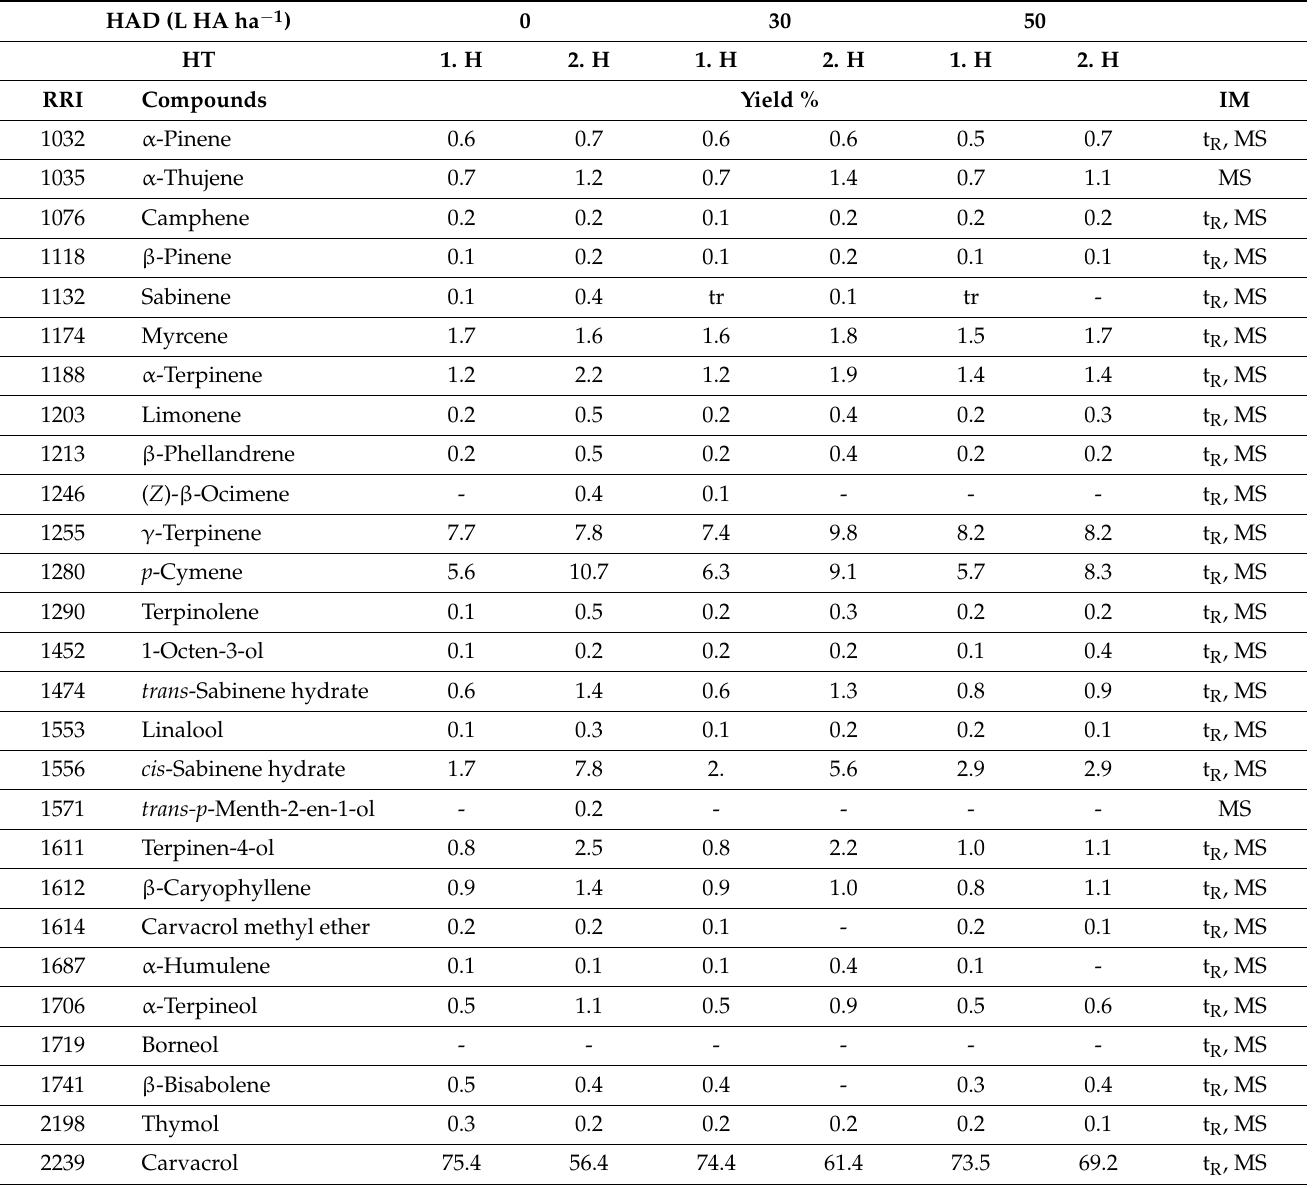
Table 6. Essential oil components of Origanum vulgare subsp. hirtum according to the different HT and HAD in